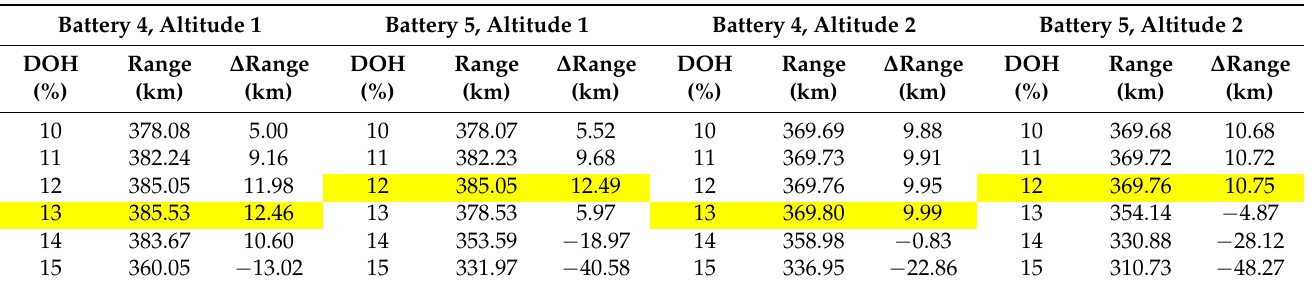
Table 3. Total mission hybridization simulation results compared to 50% DOH ICE-only cruise simulations.